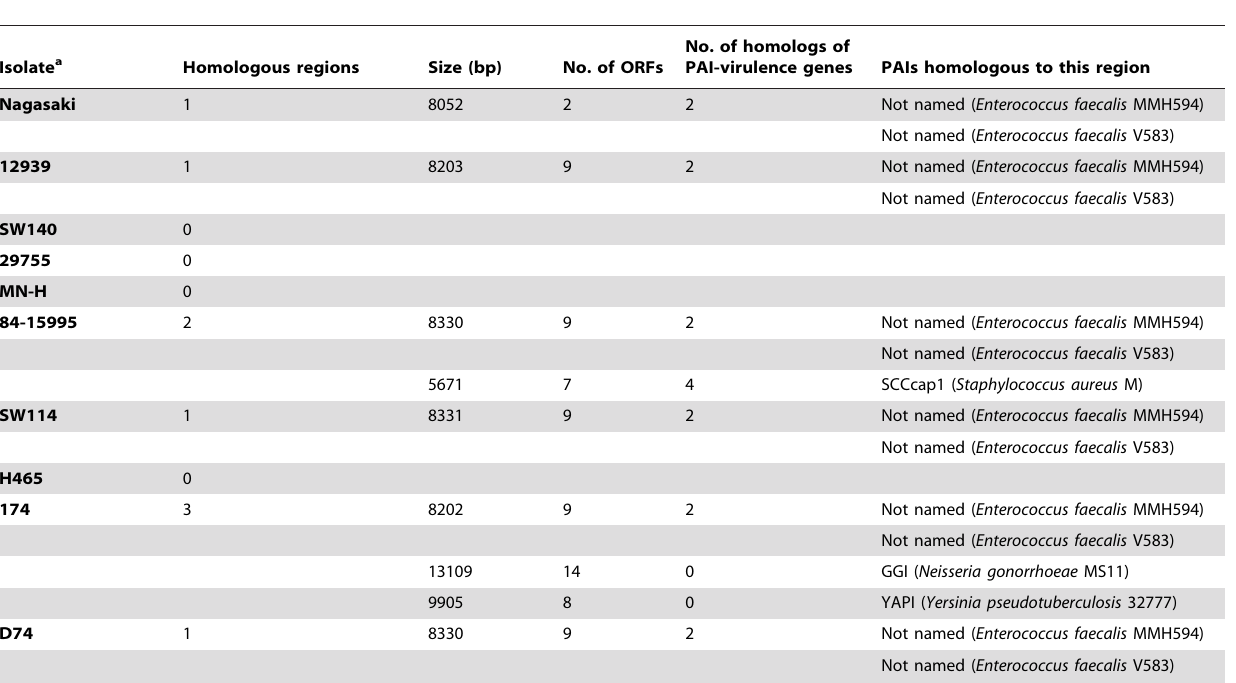
Table 7. Potential pathogenicity island homologs in H. parasuis isolates.